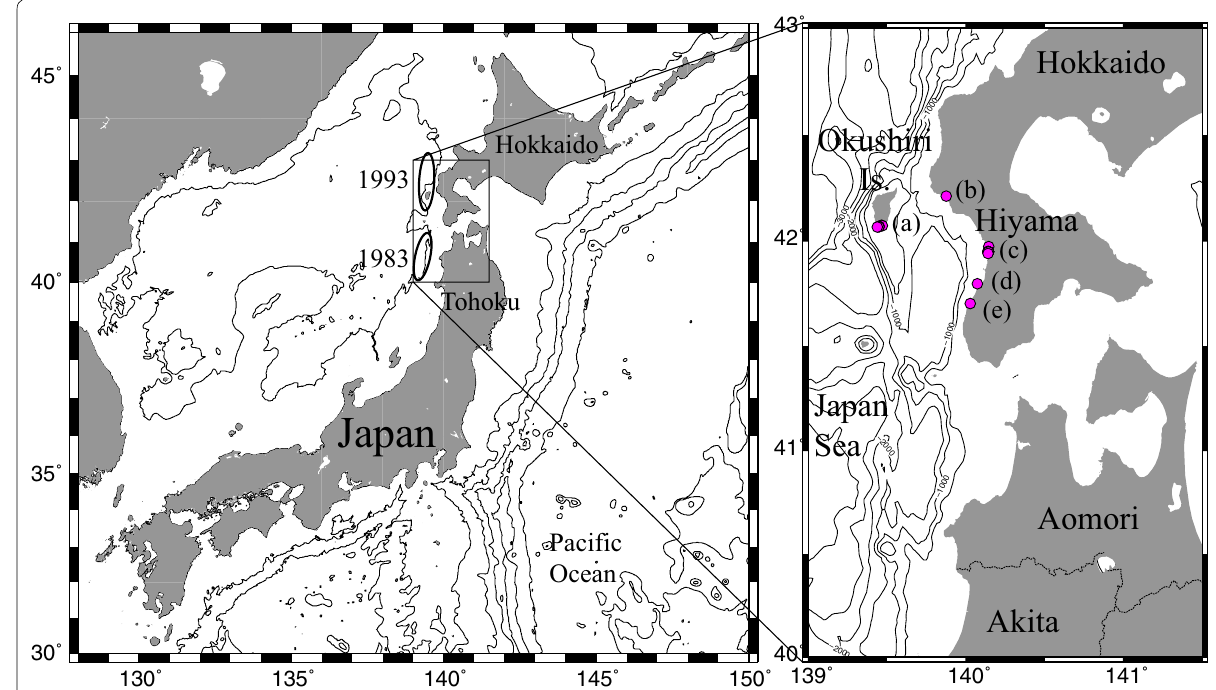
Fig. 1 The left figure is a map of Japan with a depth contour interval of 2000 m. Sources of the 1993 Hokkaido Nansei-oki earthquake and 1983 Japan Sea earthquake were shown in ellipses. The right figure is focused graphic of southwestern Hokkaido and northern Tohoku with a depth contour interval of 500 m. Tsunami deposit distributions are shown in pink circles; (a) Kaitorima on Okushiri Island, (b) Taisei in Setana town, (c) Himekawa in Otobe town, (d) Kaminokuni, and (e) Ishizaki in Kaminokuni